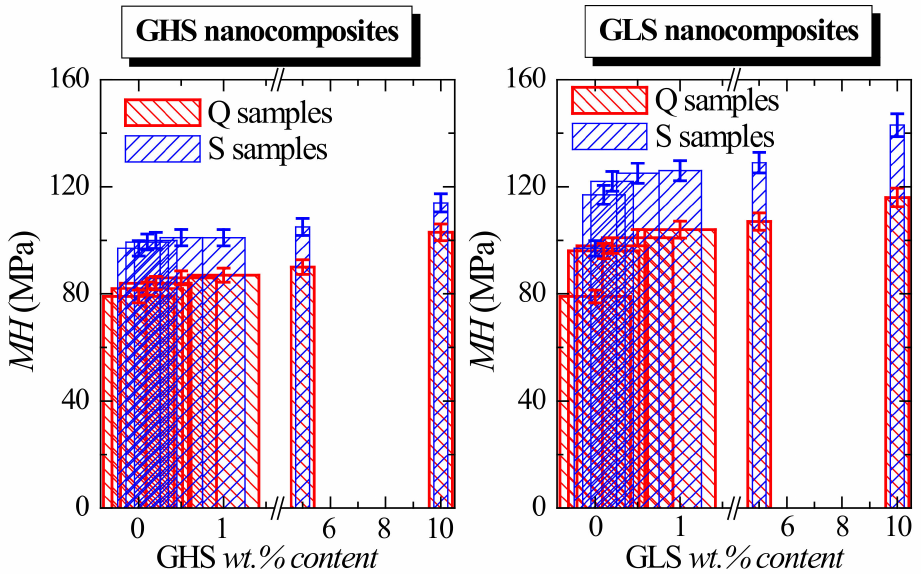
Figure 7. Values of MH , deduced from microhardness tests for the metallocene iPP matrix and nanocomposites with different contents and types of graphene